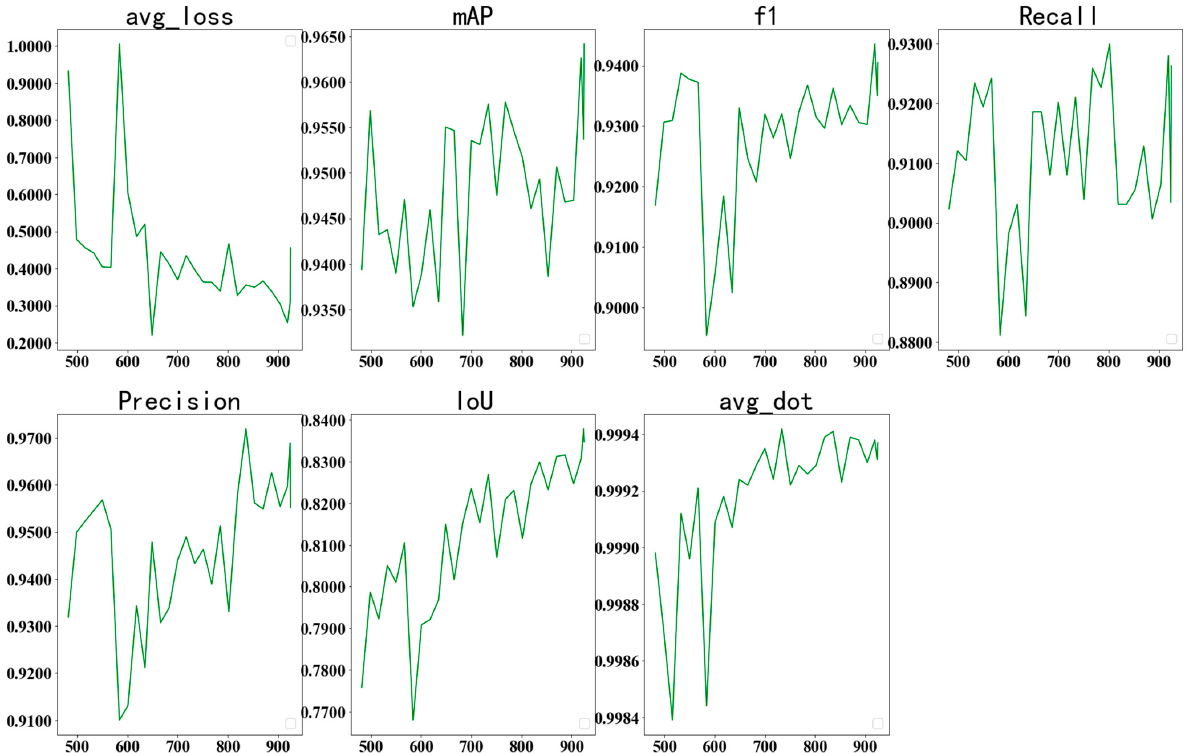
Figure 9. The changes of various indexes of HRSC data set during iteration.